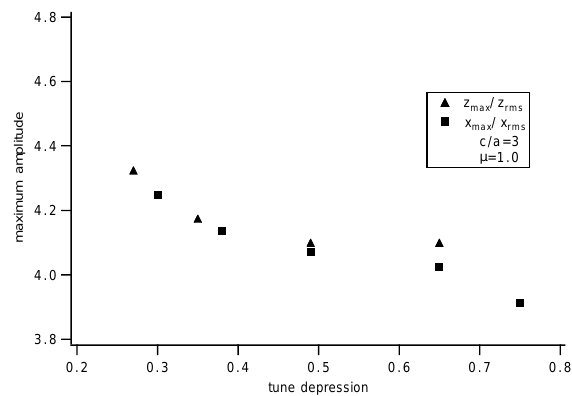
FIG. 9. The maximum particle amplitude in transverse and longitudinal directions vs transverse or longitudinal tune de- pression for an rms matched Gaussian